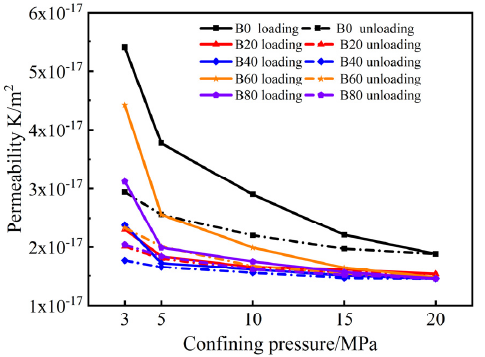
Figure 5. Variation of gas permeability with confining pressure.